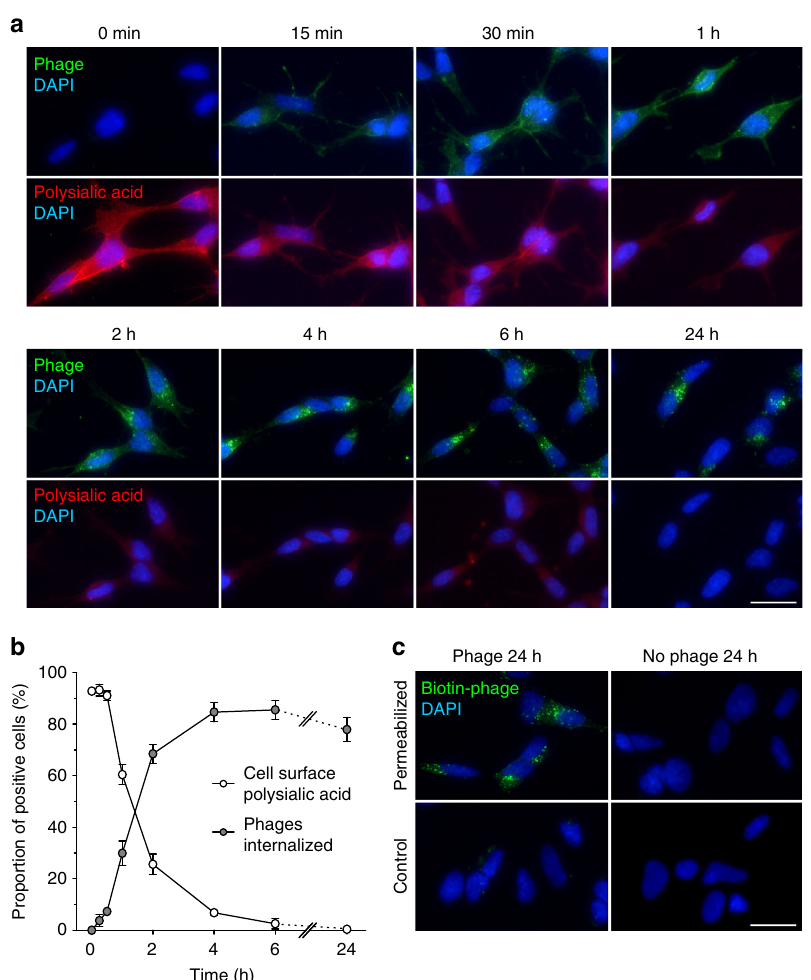
Fig. 2 Phages are endocytosed into live neuroblastoma cells. a Time course of PK1A2 phage internalization into cultured kSK-N-SH cells. Cells were incubated with FITC-labeled phages (green) at 37 °C for the times indicated, fi xed and examined for the presence of phages and surface-expressed polysialic acid (red). b Quantitative analysis of phage internalization. Data are presented as the percentages of positive cells that stained for cell surface polysialic acid or contained internalized phages and the values represent means of three randomly chosen fi elds ± s.d. of a single experiment. For each fi eld, at least 60 cells were examined. c Immuno fl uorescence detection of internalized biotin-conjugated phages after 24 h of incubation. Control cells or cells permeabilized with 0.2% Triton X-100 were stained with Alexa Fluor 488 FluoroNanogold-streptavidin (green). Cells without phages were used as control of staining speci fi city. Nuclei were stained with DAPI (blue). All data shown are representative for two biological replicates. The scale bars represent 20 µ